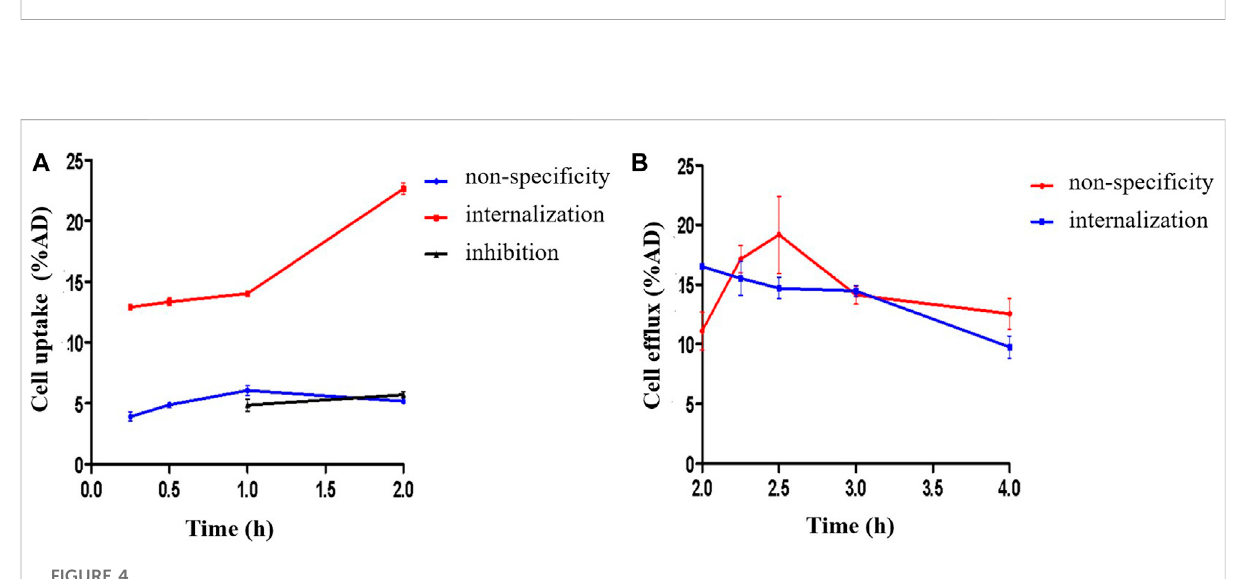
FIGURE 3 Prep-HPLC chromatogrm (A) and HPLC radiochromatograms of puri fi ed 18 F-VUIIS1008 (B) and radiola-beled probe after 30 min (C) , 60 min (D) , 120 min (E) and 240 min (F) of incubation with mouse serum.